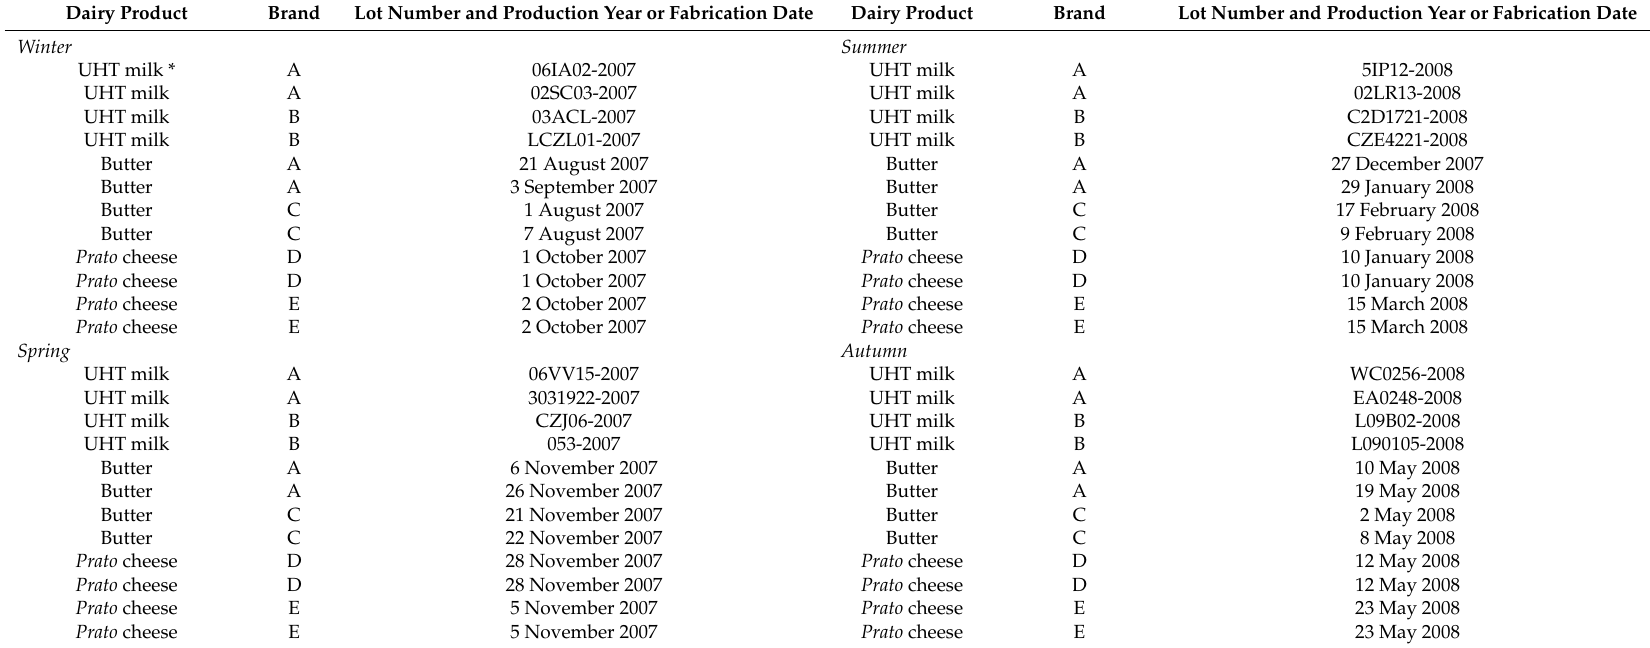
Table 1. Details of samples of commercial dairy products (whole milk, butter from unfermented cream, and prato cheese) acquired in hypermarkets. Dairy